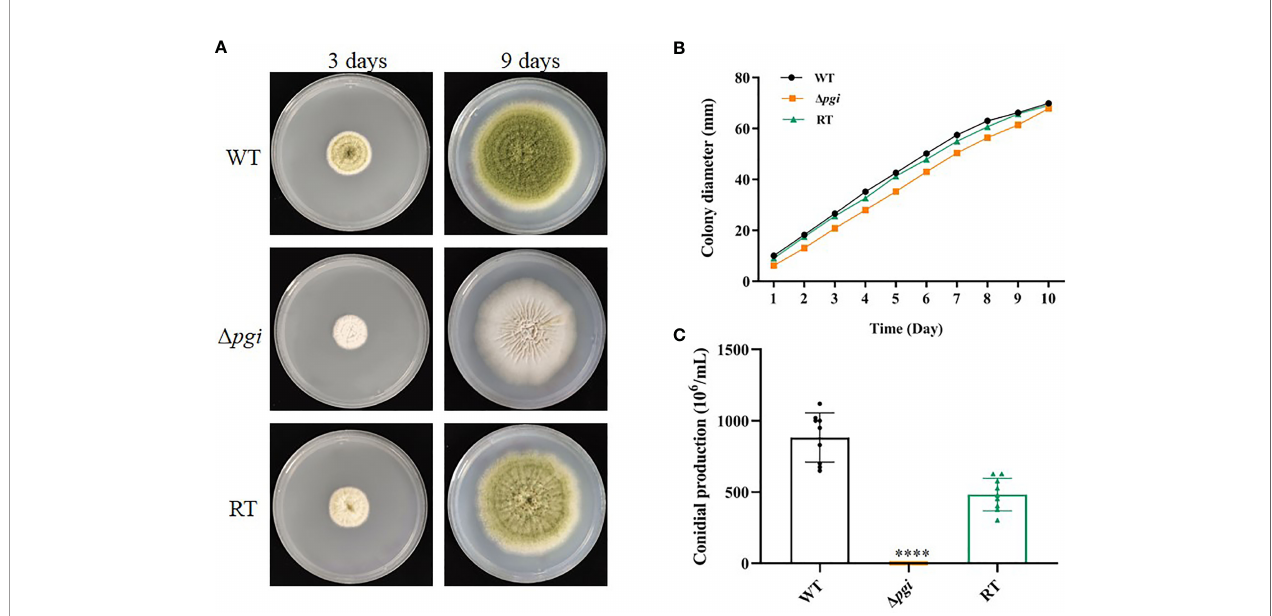
FIGURE 2 | Growth of the D pgi mutant on MMFG. (A) The WT, D pgi , and RT strains were grown on MMFG solid medium for 3 and 9 days; (B) 10 5 conidia of the WT, D pgi , and RT strains were inoculated onto solid MMFG medium and cultured at 37°C for 10 days. Colony diameter was measured daily. Three replicates were performed, and data were shown as mean ± SD ; (C) After cultivation at 37°C for 10 days, conidia were harvested and counted using a hemocytometer. Values represent the mean ± SD ; multiple t test analysis was used to indicate statistical signi fi cance (**** p <